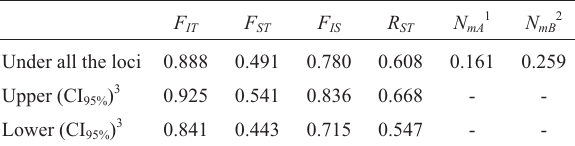
Table 5 - Estimates of Wright’s F statistics, R ST and the number of migrants per generation ( N m ) for eleven natural Brazilian Oryza glumaepatula populations. F IT F ST F IS R ST N mA 1 N mB 2 Under all the loci 0.888